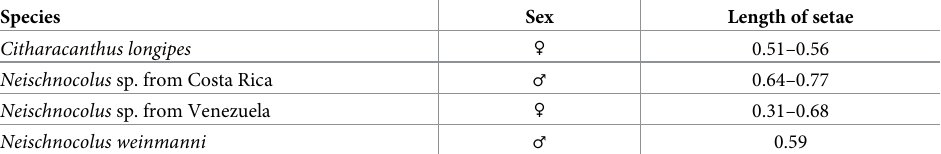
Table 6. Length ranges of subtype I d setae.